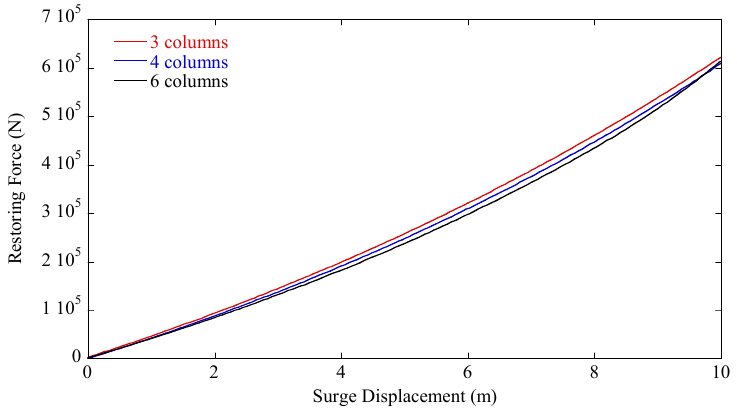
Figure 5. Restoring force as a function of surge displacement. Table 3. Load conditions in the free-decay test. LC = load condition.